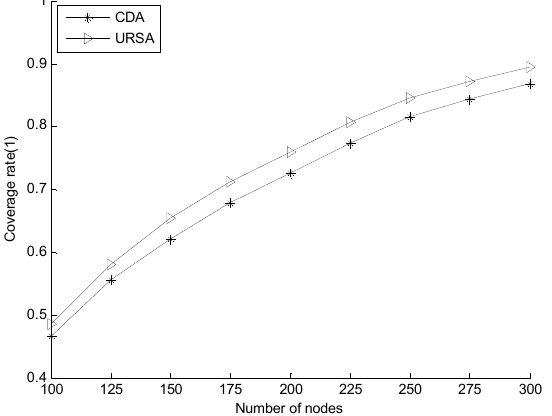
Figure 12. Comparison of network coverage rate for varying numbers of nodes. CDA, CDS-based depth computation algorithm.